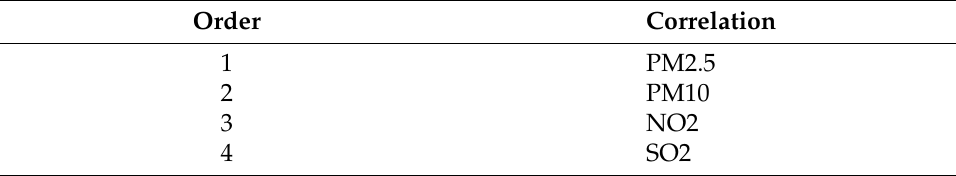
Table 3. Chemical Base of Feature